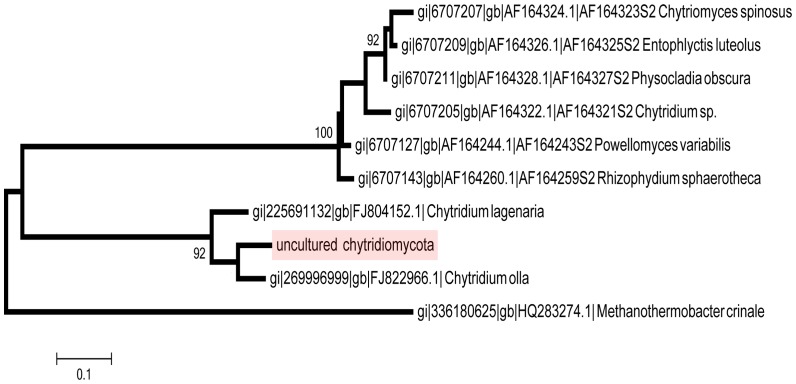
Phylogenetic tree of 18S rRNA gene sequences of uncultured Chytricomycota.